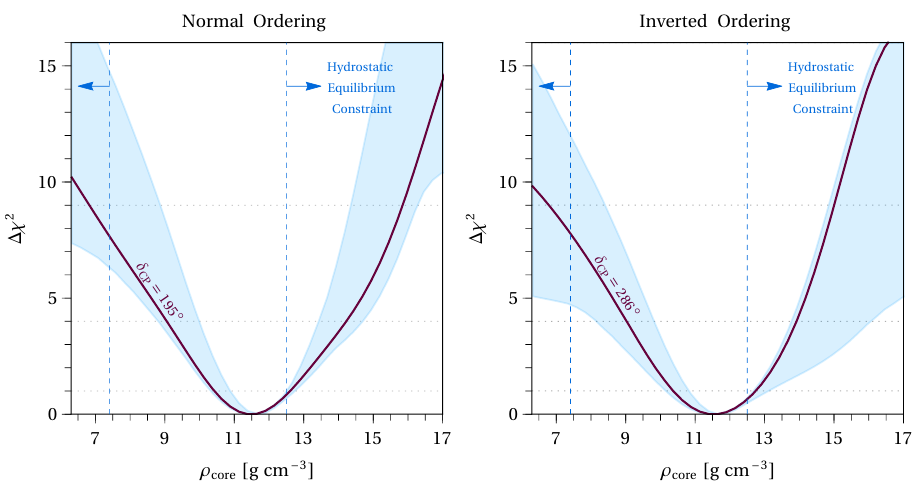
Figure 15 . DUNE’s 400 kton-year sensitivity to the core matter density ρ core , assuming the density profile to be constrained by the total mass and moment of inertia of the Earth. The left (right) panel assumes that neutrinos follow the normal (inverted) mass ordering, where both assume that the ordering is known from the neutrino beam data. The blue band encodes different true values of δ CP , while the current global best fit is highlighted (purple lines).